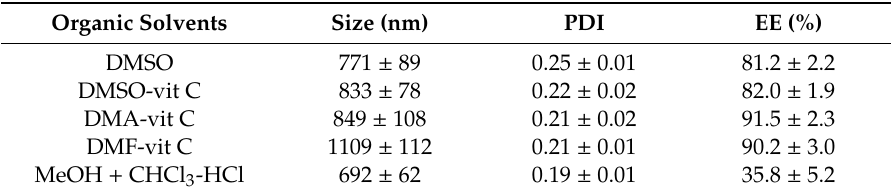
Table 2. E ff ect of organic solvent on liposomal AmB prepared by the supercritical fluid of carbon dioxide (SCF-CO 2 ) method.